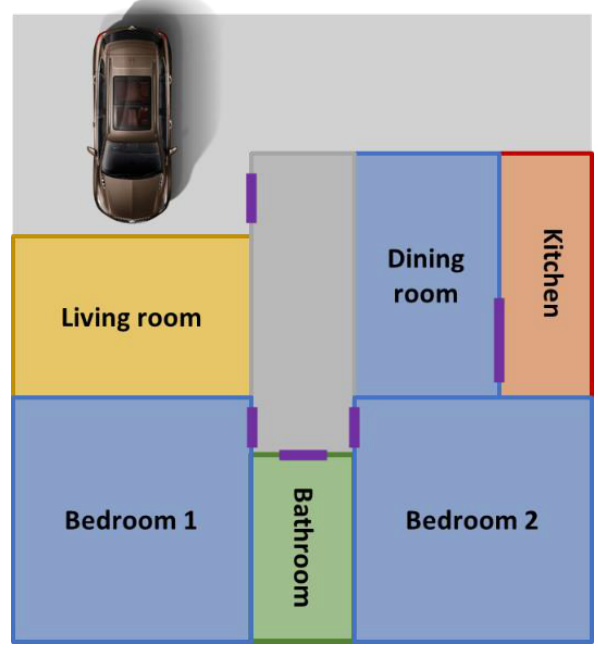
Figure 5. Visual representation rooms of the house.